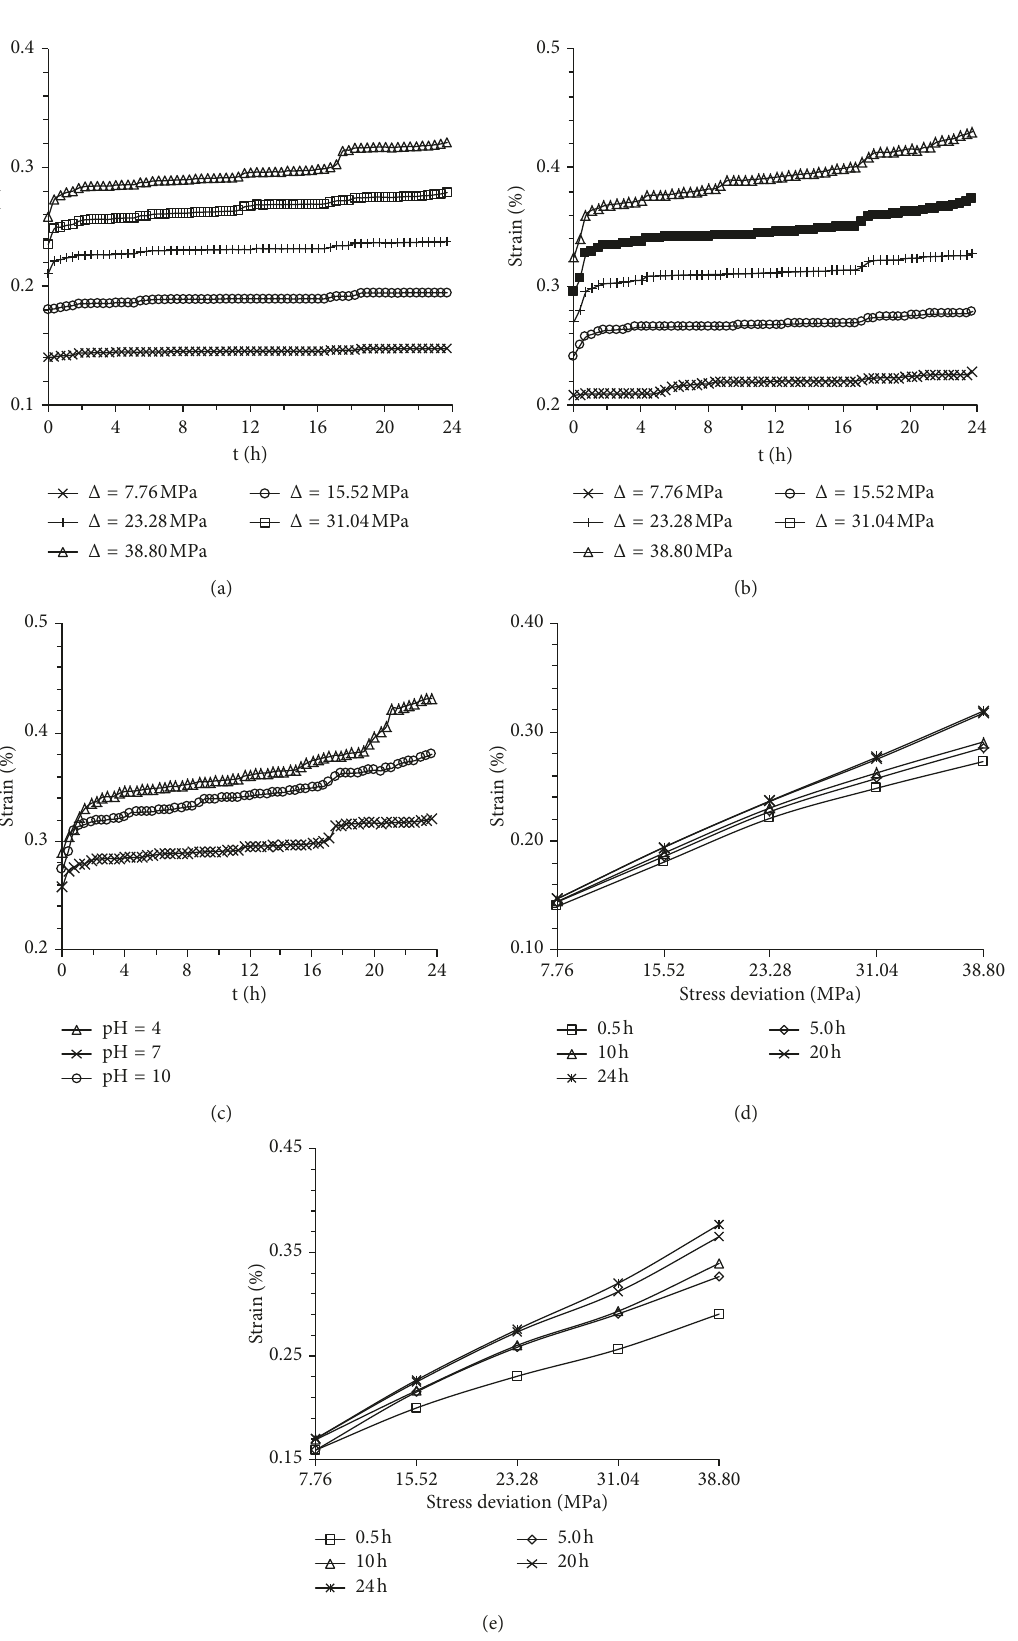
7). (b) Strain-time curves (pH 10). (cid:30) (cid:30) 7). (cid:30)